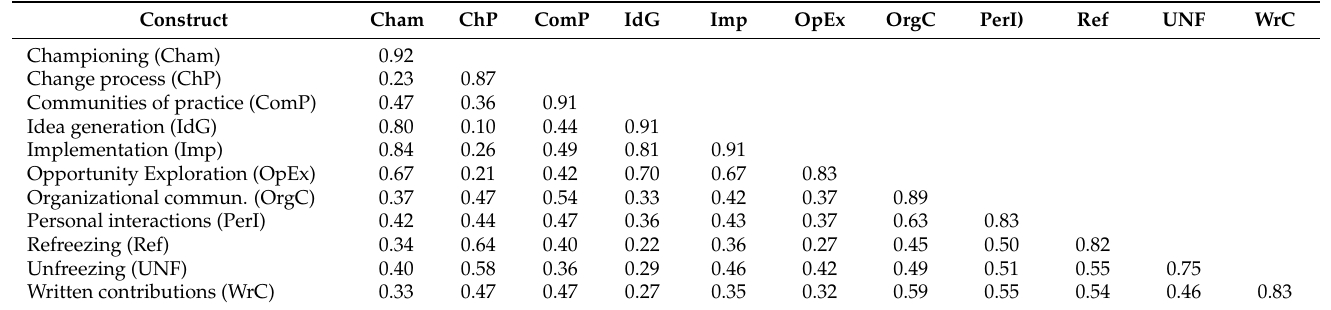
Table 3. Discriminant validity.